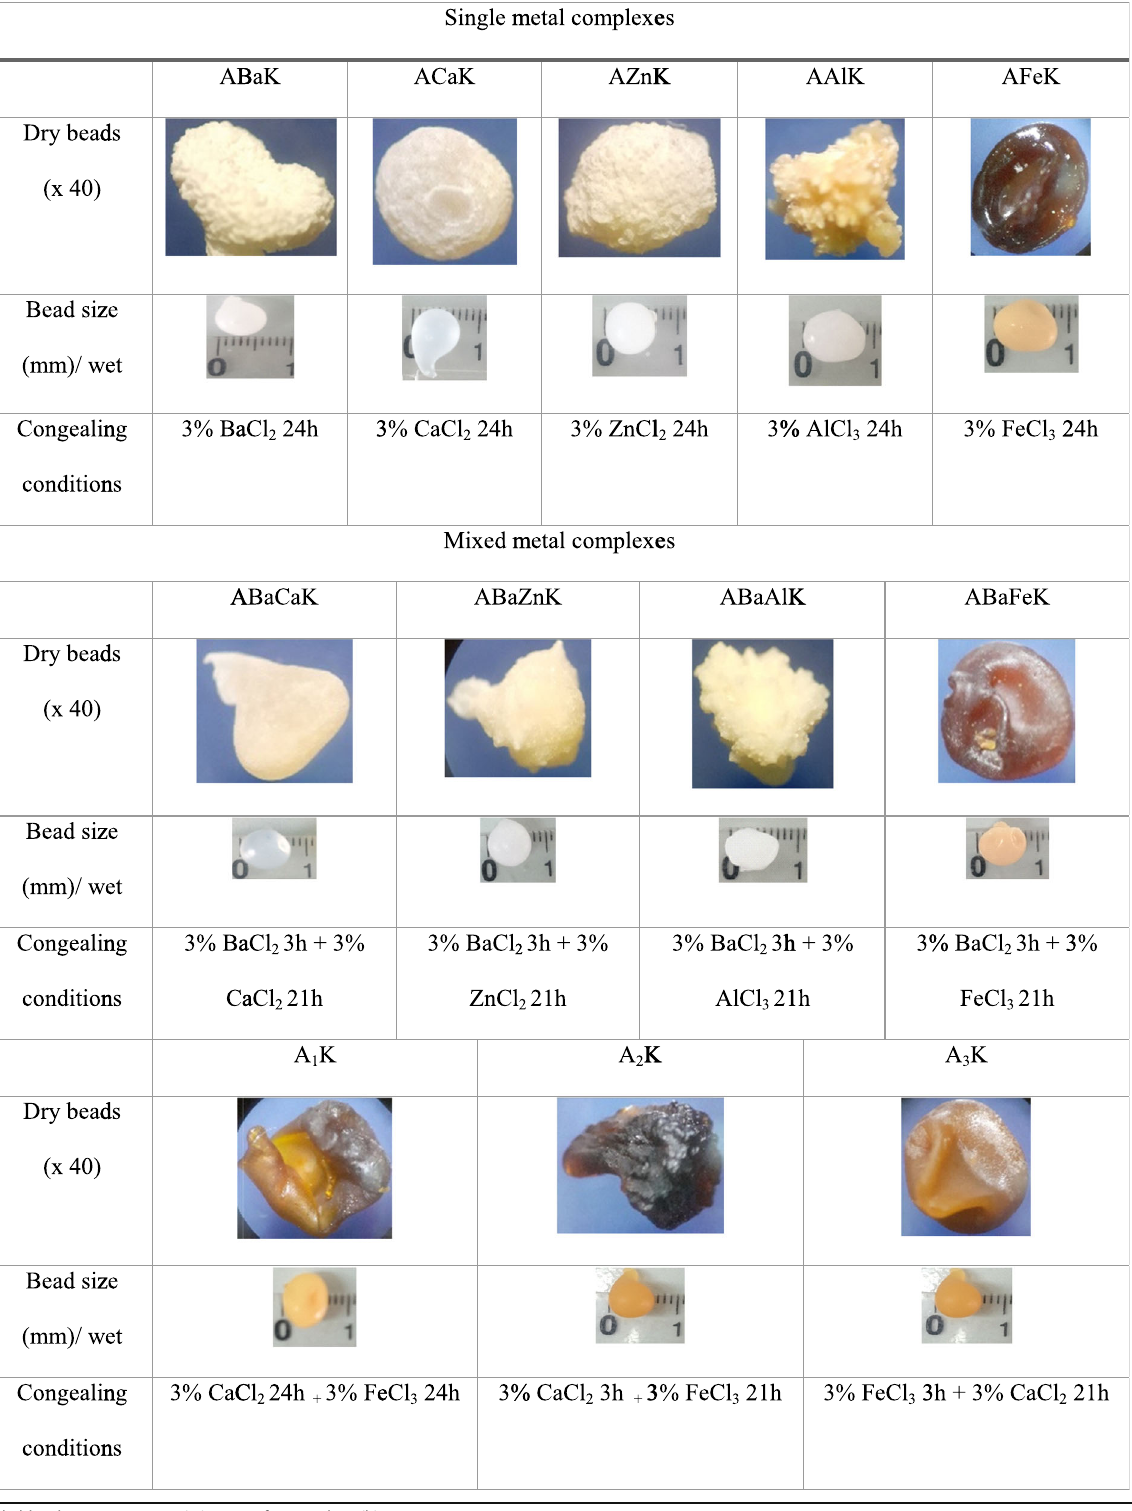
Table 3 Shape, size, and congealing conditions of the prepared beads used in this